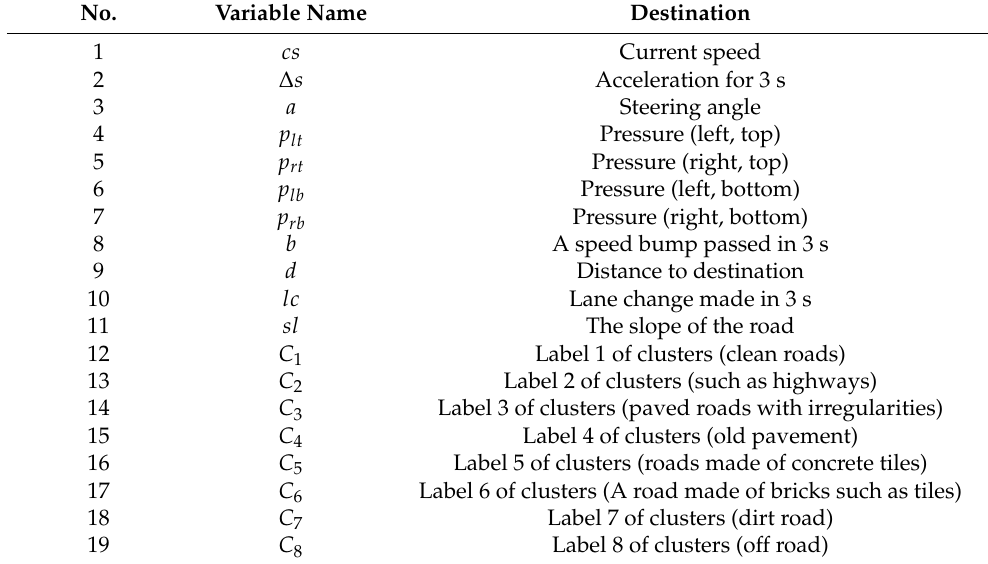
Table 1. Input data set and clusters the